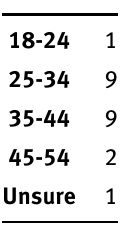
Non-binary/Chose to not specify